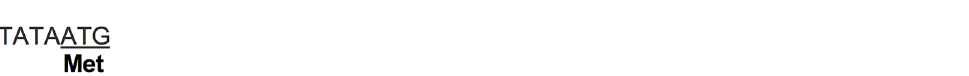
the highest level of biofilm formation (Fig. S1a–d) 38 . These results revealed that Δ rovM formed more vigorous biofilms than the wild-type strain in this C. elegans model. Strikingly, there was no biofilm formation observed on nematodes infected with the complemented strain (Fig. 4a). This result was further confirmed by examining biofilm formation on abiotic surfaces (Fig. 4b). Consistent with the report that the hmsHFRS gene locus is essen- tial for biofilm formation in Y. pseudotuberculosis , there was no biofilm formation observed on the nematodes infected with the Δ rovM Δ hmsHFR double mutant (Fig. 4). Together, these findings indicate that RovM plays a negative role in biofilm formation via suppressing the production of β -GlcNAc exopolysaccharide.